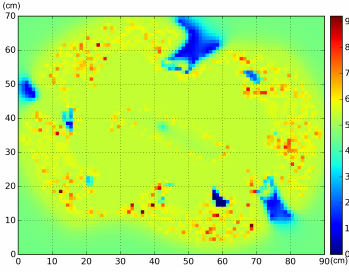
Figure 25. Overall expected duration.